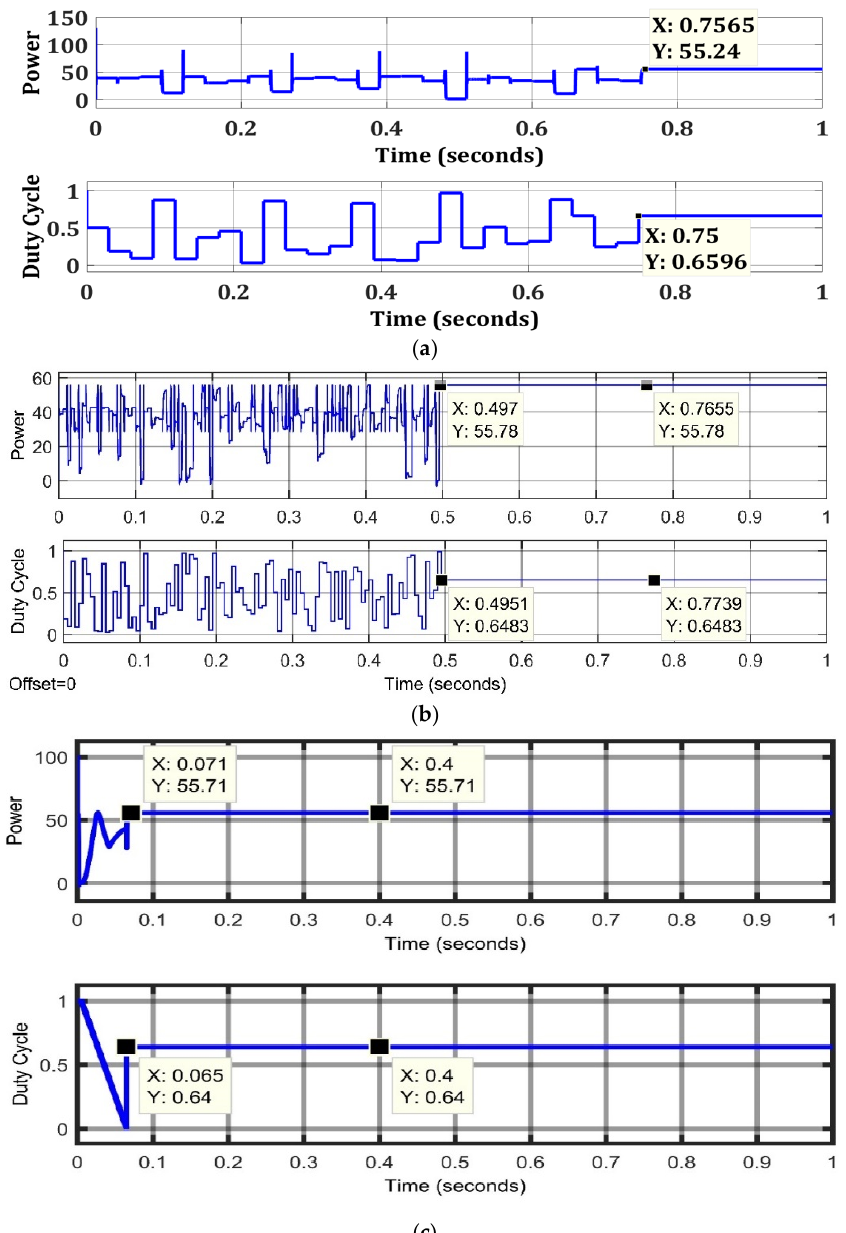
Figure 7. Characteristic curve of 4S PV array under weak partial shading.